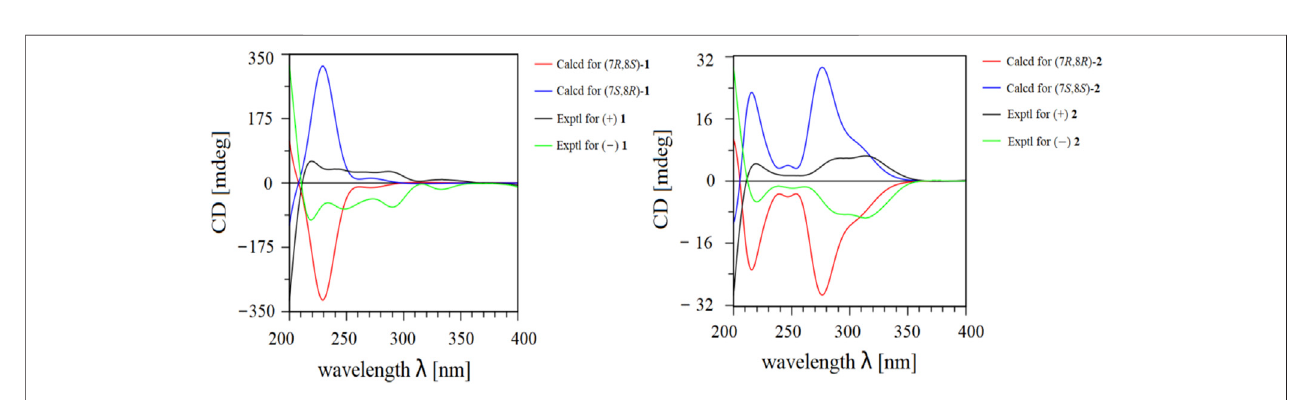
FIGURE 3 | Experimental and calculated ECD data of (±) 1 and (±) 2